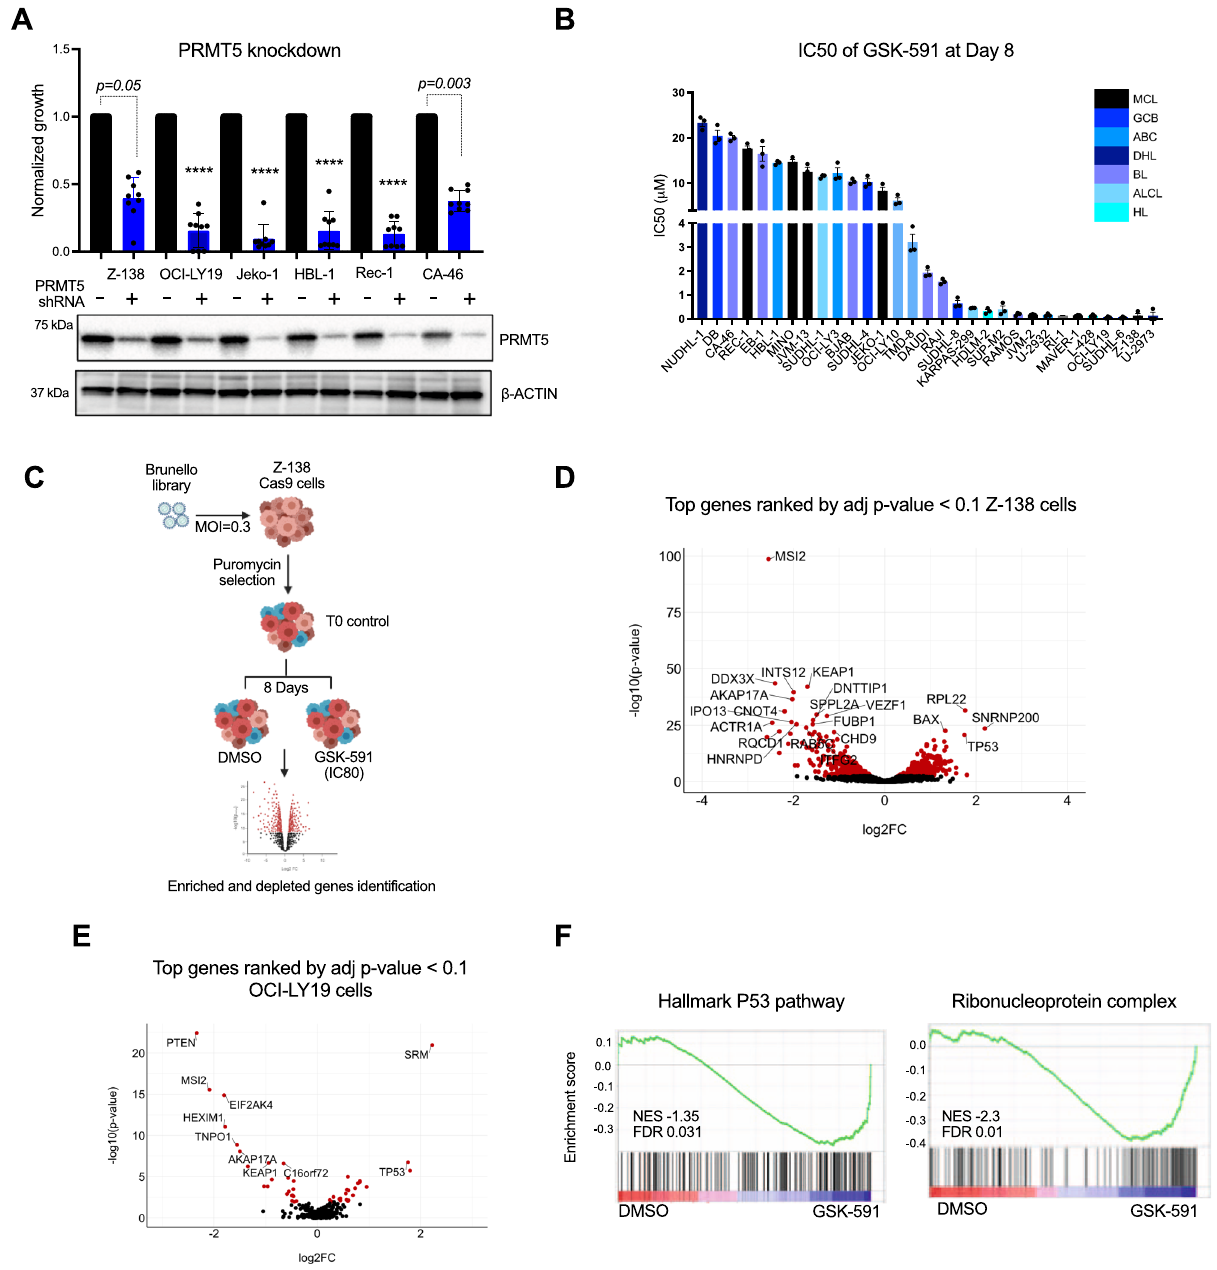
Fig. 1 | Genome-wide CRISPR/Cas9 KO screen identi fi ed controllers of sensi- tivity and resistance to PRMT5 inhibition. A Lymphoma cells were cells trans- ducedwithlentivirusexpressingshRNAtargetingPRMT5orscramble.Cellviability and immunoblot analysis were assessed 5 days after transduction and puromycin selection. Data represent mean±SEM of n =3 replicates examined over 3 inde- pendent experiments. p- values are indicated, ****p <0.0001, statistical analysis by two-sided Student ’ s t test. B BargraphshowingIC50valuesofGSK-591after8days of treatment in 31 lymphoma cell lines from different lymphoma subtypes: Mantle cell lymphoma, Germinal center DLBCL (GCB), Activated B-cell DLBCL (ABC), Double hit lymphoma (DHL), Burkitt ’ s lymphoma (BL), Anaplastic large cell lym- phoma (ALCL) and Hodgkin ’ s lymphoma (HL). Cell viability was monitored by Celltiter-Gloassay.ErrorbarsrepresentSEMoftriplicateexperiments. C Schematic representation of the GSK-591 CRISPR-Cas9 negative screening strategy in Z-138 Cas9 cells. D Volcano plot comparing signi fi cance of enrichment/depletion and